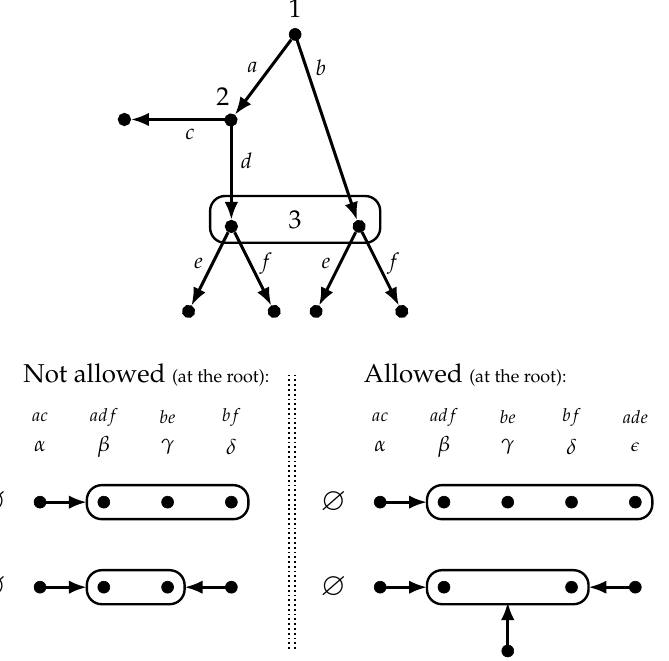
Figure 8. A game and four partial models of it (showing only the beliefs of Player 1 at history ∅ ), two of which violate Condition 5 of Definition 6 and the remaining two do